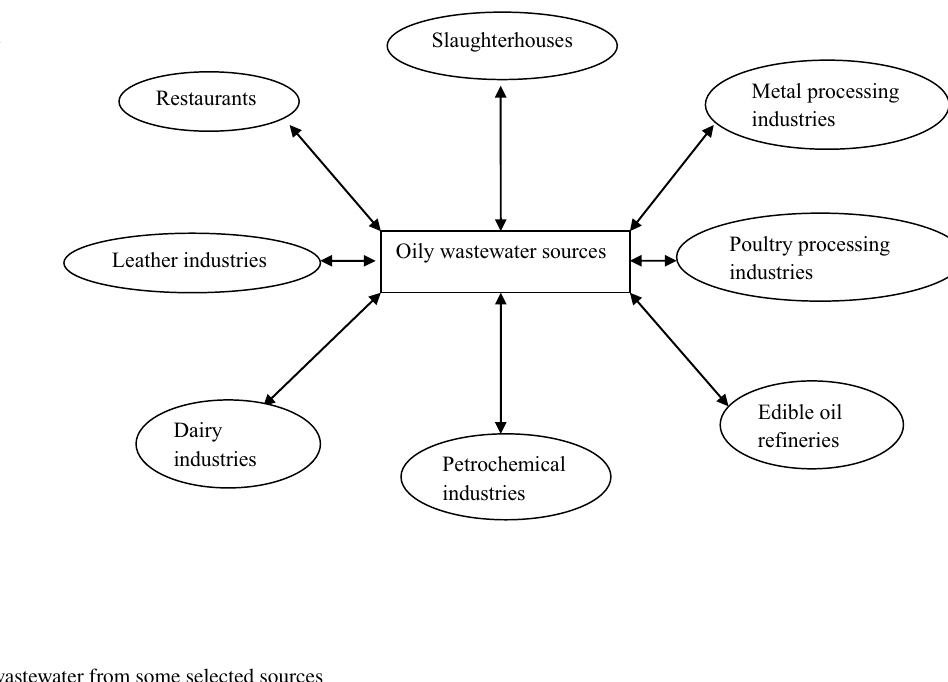
Table 1 Pollutant load of oily wastewater from some selected sources Oily wastewa- ter